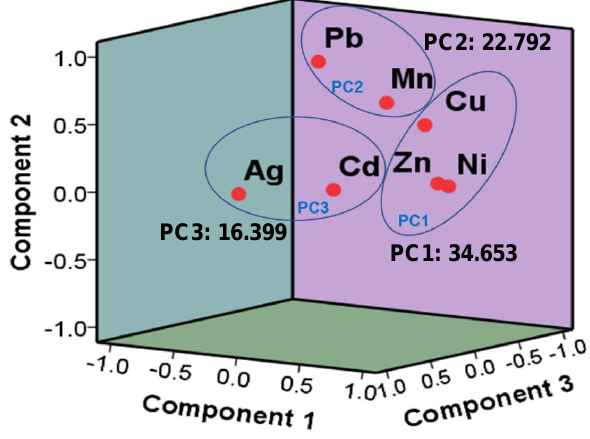
Figure 6. Principal component analysis (PCA) of heavy metals in the Han River watershed.